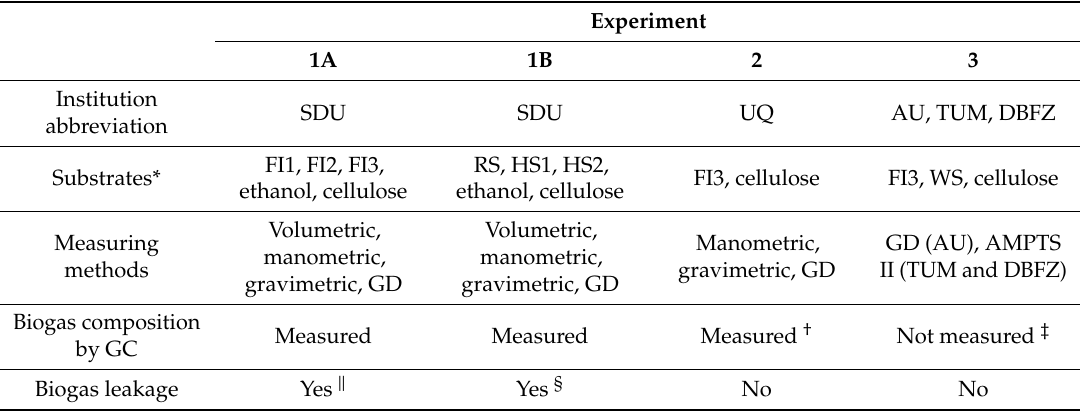
Table 1. Summary of the four experiments used for evaluation of the gas density BMP method